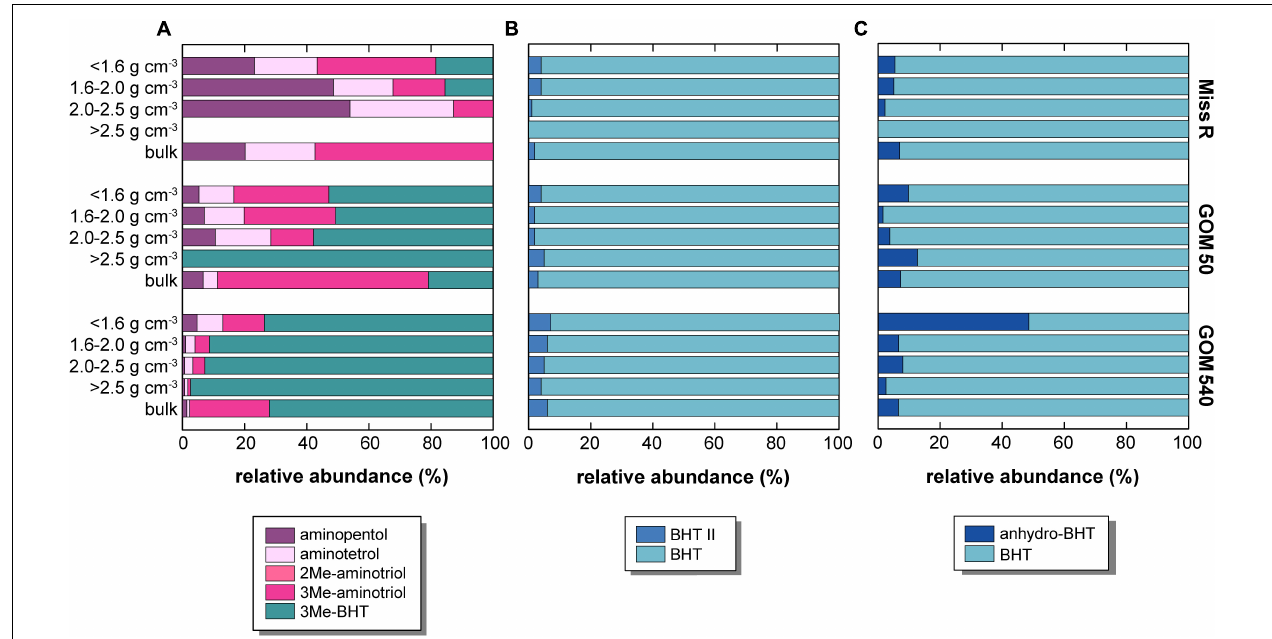
FIGURE 8 | Relative abundance of selected BHP sub-pools in density fractions and bulk sediment samples along the Miss R – GOM transect. (A) Relative abundance of putative methanotrophic BHPs, (B) relative abundance of BHT II and BHT (BHT II ratio), and (C) relative abundances of anhydro-BHT and BHT.